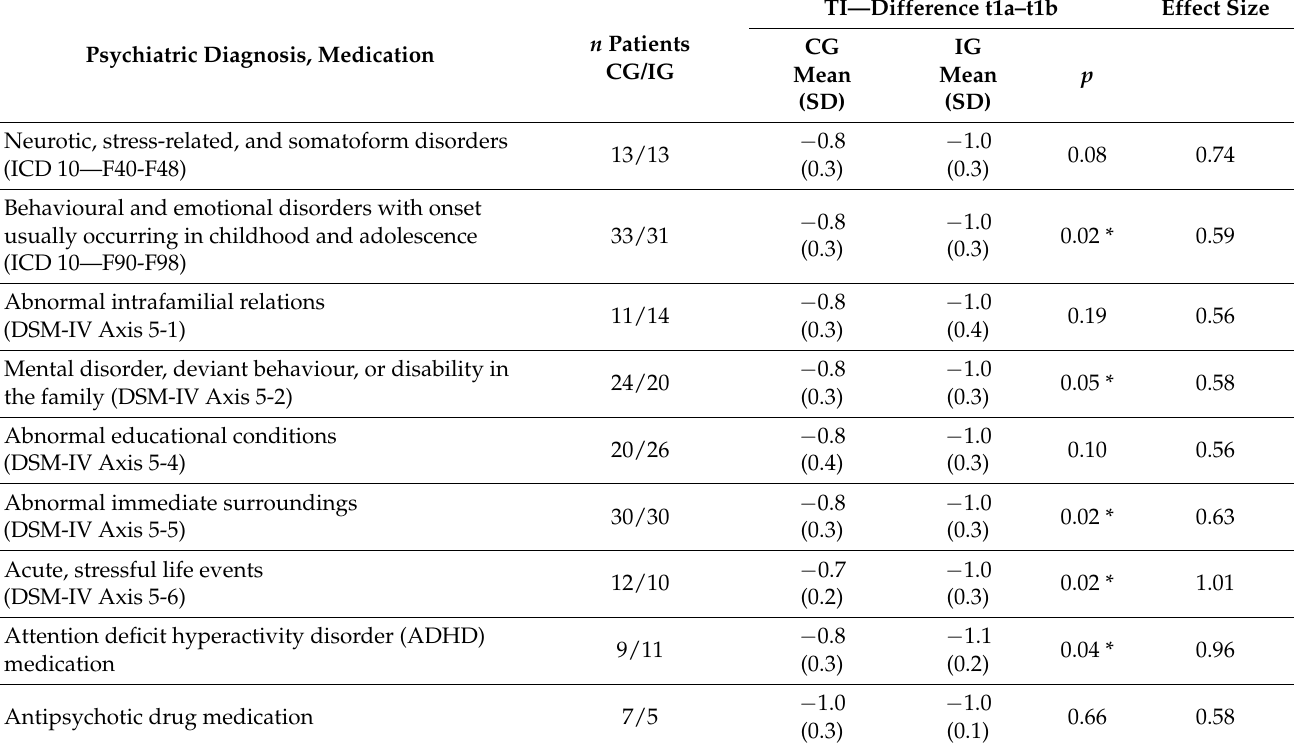
Table 6. Dental plaque reduction rates in IG and CG after autonomous tooth brushing in mental disorder groups and effect size of IndOHCT.